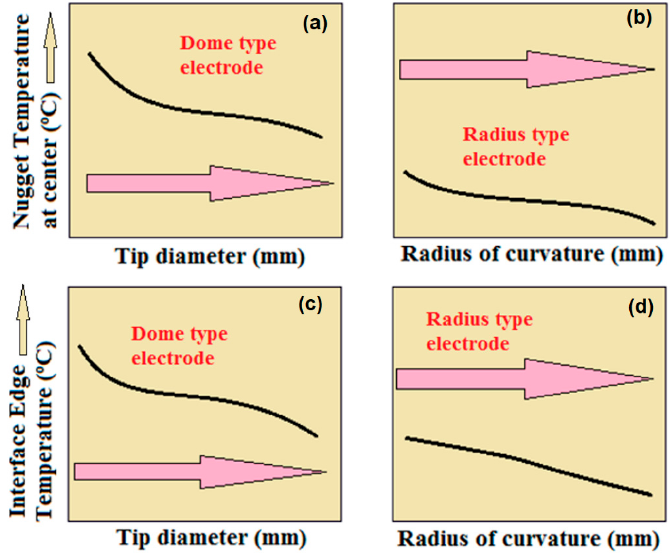
Figure 12. Temperature at the electrode–surface interface: ( a ) temperature at the center part (nugget) with a diameter of dome electrode; ( b ) temperature at the center with radius-type electrode; ( c ) temperature at the edge with a diameter of dome electrode; and ( d ) temperature at the edge with radius-type